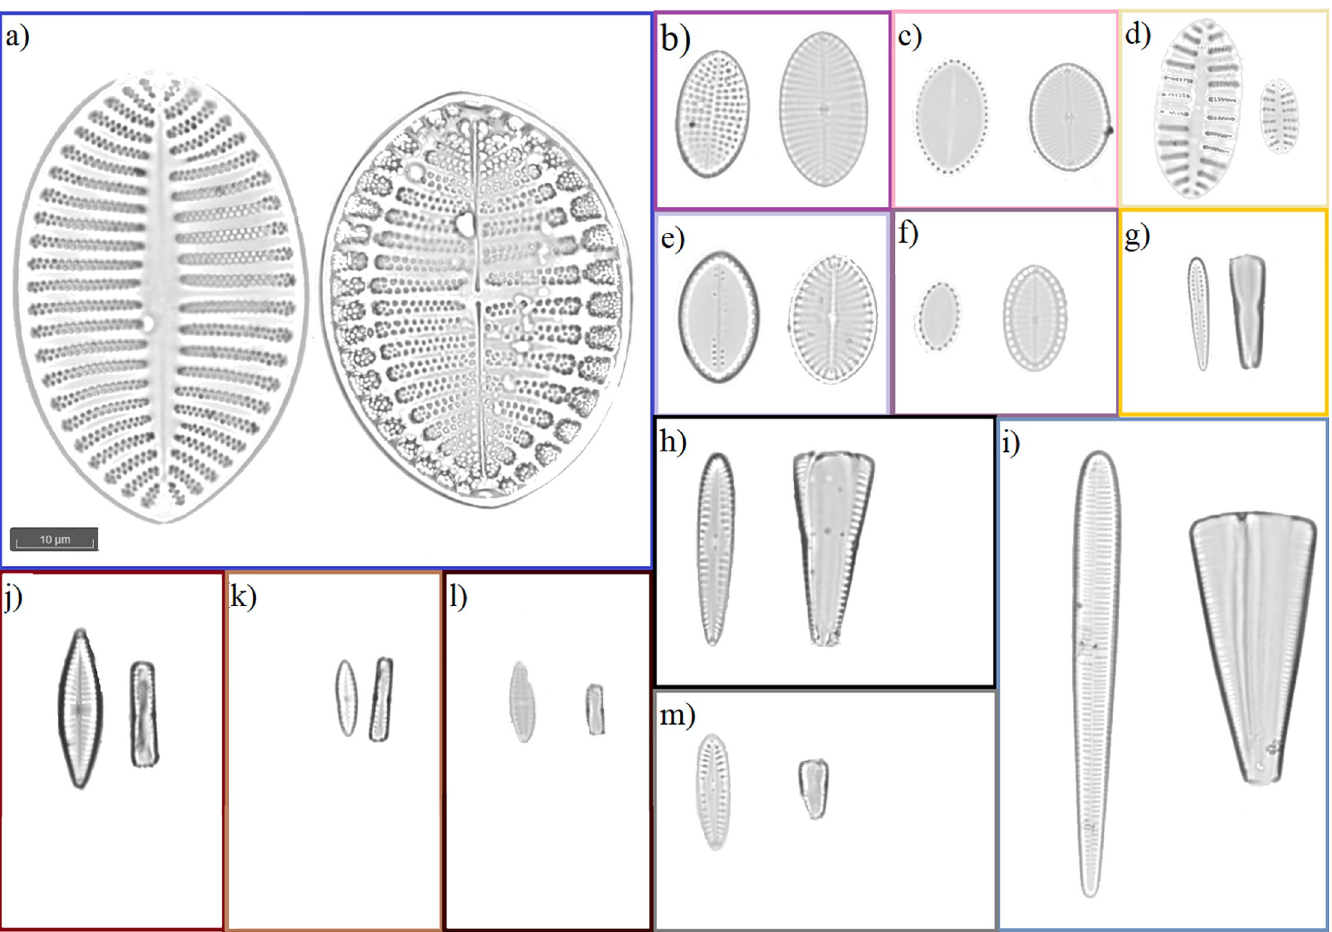
Fig 2. Predominant diatoms found on Antarctic macrophytes. Monoraphid diatoms shown in raphe and raphe-less valve view. Biraphids shown in valvar and pleural view. a) Cocconeis fasciolata , b) Cocconeis californica var . californica , c) Cocconeis dallmannii , d) Cocconeis sp . 1 , e) Cocconeis californica var . kerguelensis , f) Cocconeis melchioroides , g) Gomphonemopsis cf . ligowskii , h) Pseudogomphonema kamtschaticum , i) Licmophora gracilis , j) Navicula glaciei , k) Navicula incertata , l) Navicula perminuta , m) Pseudogomphonema sp . 1 .